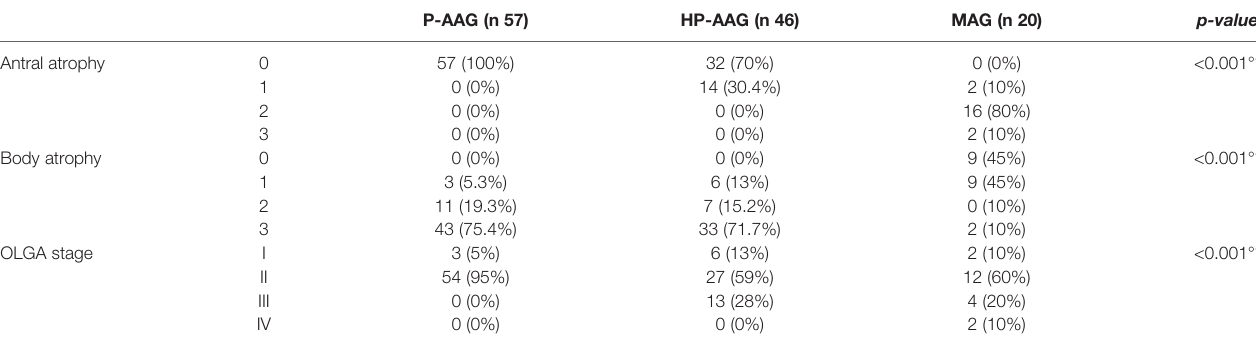
TABLE 1 | Histological characteristics in AAG compared to MAG patients.